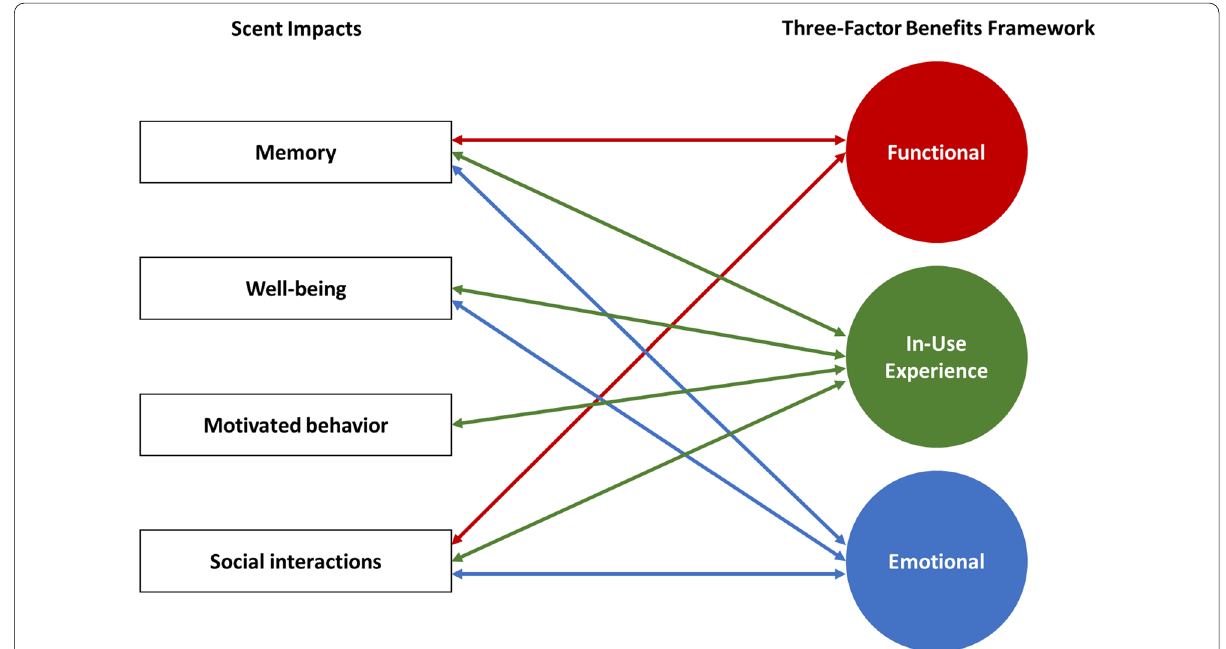
Fig. 2 Bidirectional interactions between scent impacts and consumer benefits in the three-factor